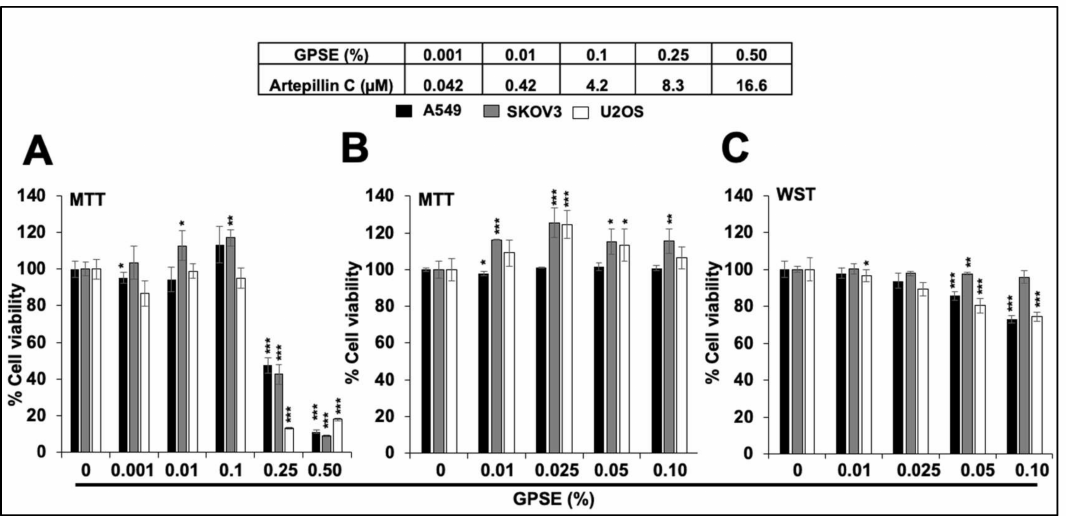
Figure 1. GPSE, at a low dose, is non-cytotoxic to human cancer cells. Dose dependent cytotoxicity of GPSE is shown. Effect of a wide range of GPSE concentrations (0.001 to 0.50%) showed cytotoxicity at the 0.25% and 0.50% in all the three cell lines ( A ). The low concentrations (0.001 to 0.10%) were confirmed to be non-cytotoxic by repeated MTT ( B ) as well as WST ( C ) assays. The quantified cell- viability data represents mean ± SD obtained from three independent biological replicates; p -values were calculated using unpaired Student’s t -test. * < 0.05, ** < 0.01, and *** < 0.001 represent significant, very significant, and very very significant, respectively.